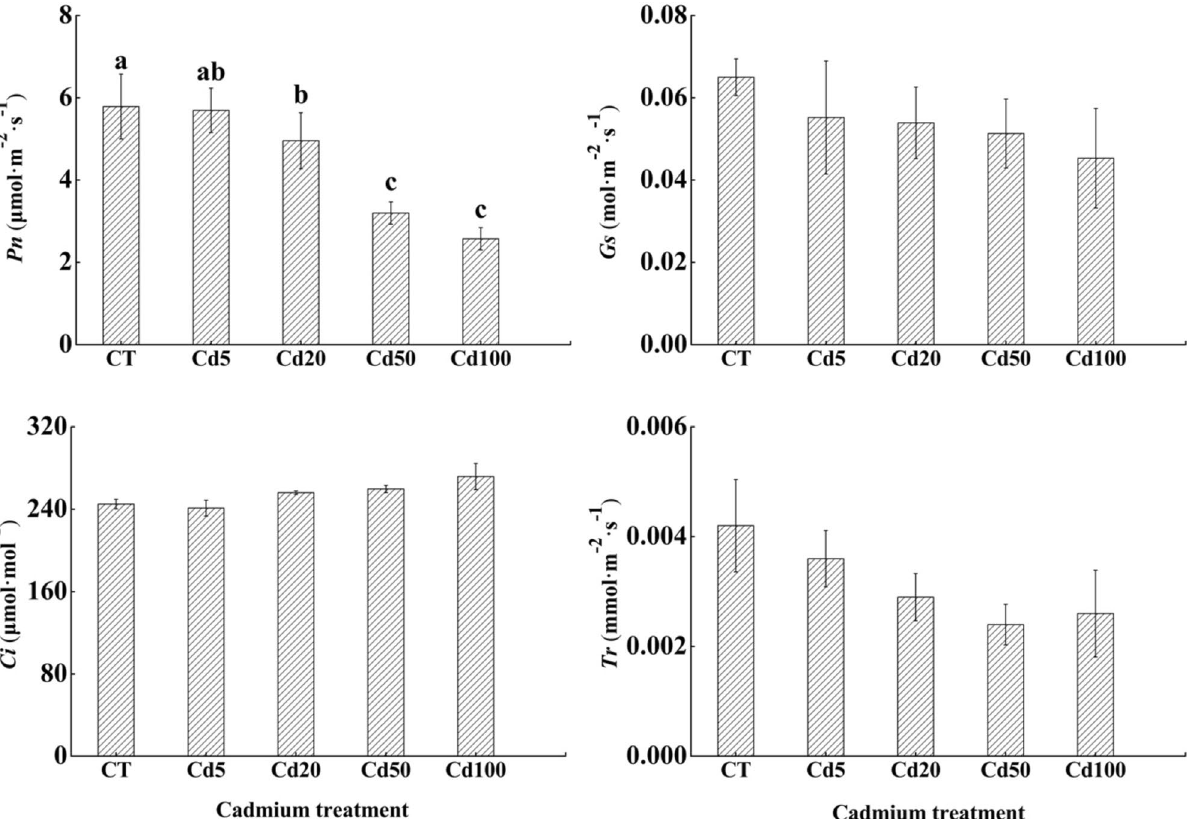
Figure 5. Photosynthetic gas exchange parameters of sassafras leaves under different cadmium stress treatments.